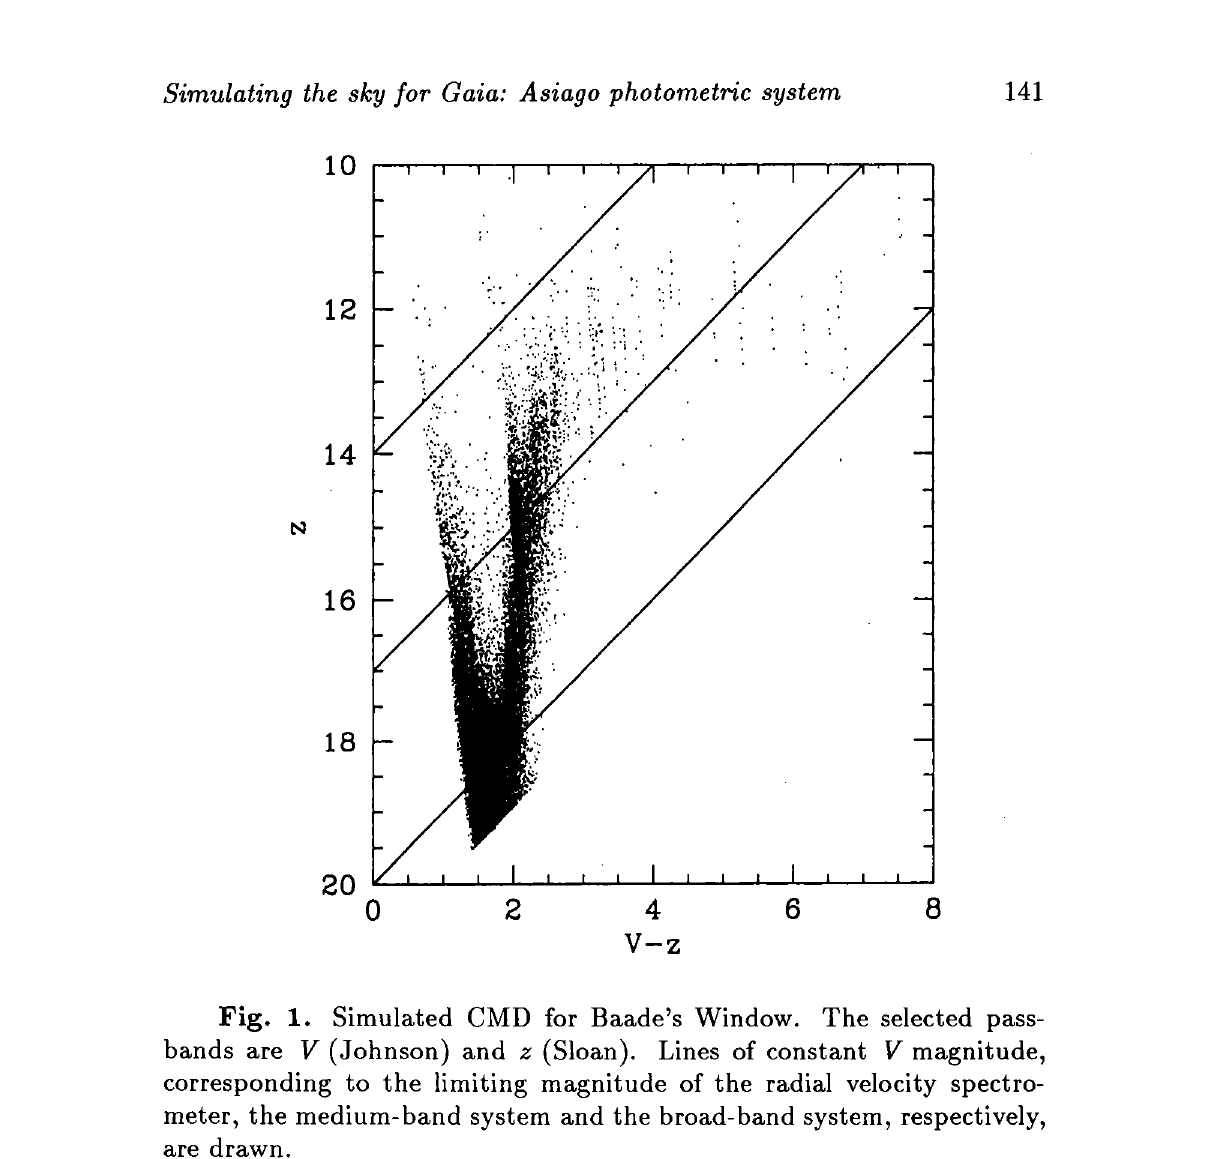
Fig. 1. Simulated CMD for Baade's Window. The selected pass- bands are V (Johnson) and ζ (Sloan). Lines of constant V magnitude, corresponding to the limiting magnitude of the radial velocity spectro- meter, the medium-band system and the broad-band system, respectively, are drawn. roo L= F(X)dX (4) Jo and the constant C is defined by assuming for the Sun BCQ = —0.08 and C = 4.75 with My© = 4.83. Note that the Eq. (3) actually defines the bolometric magnitude scale. Large grids of BCs and colors {V — m^x) are thus computed at varying T fr, gravities and e